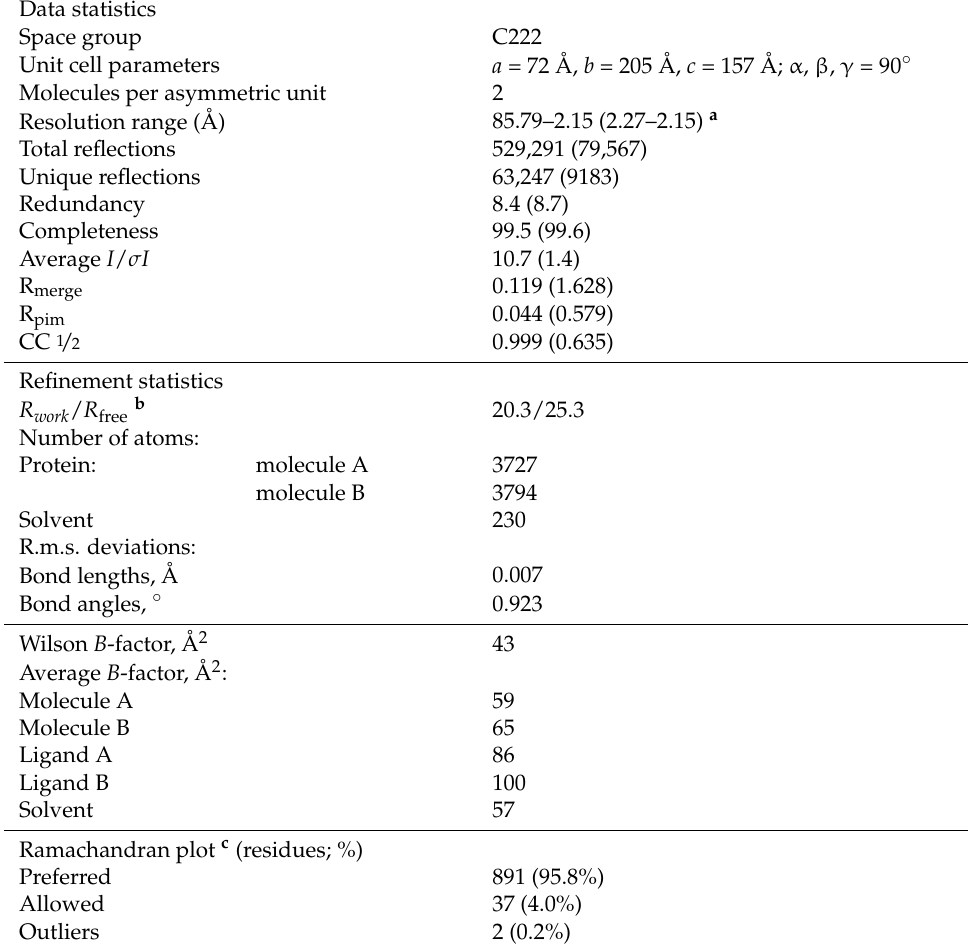
Table 2. X-ray data collection and structure refinement